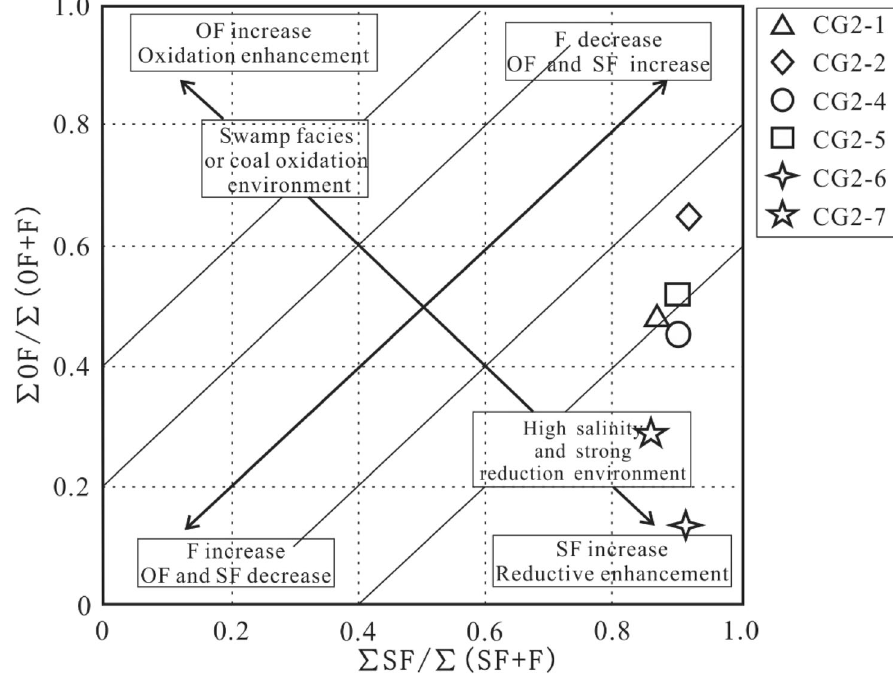
Fig. 5 The P SF/ P (F ? SF) and P OF/ P (F ? OF) diagram of the samples. Modified from Li and He